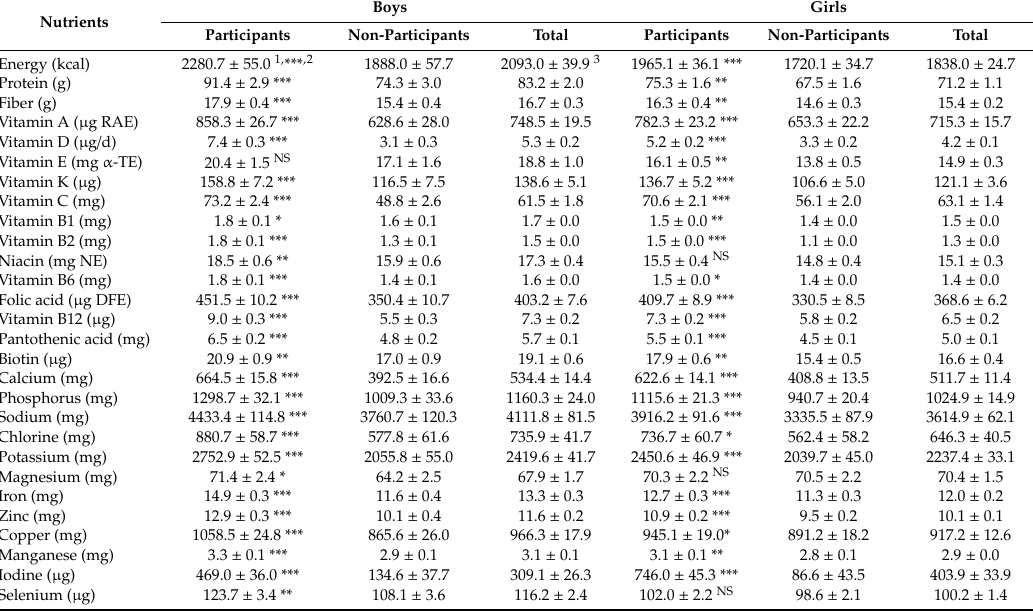
Table 3. Daily nutrient intake of participants and non-participants in the school milk program in South Korea. Nutrients